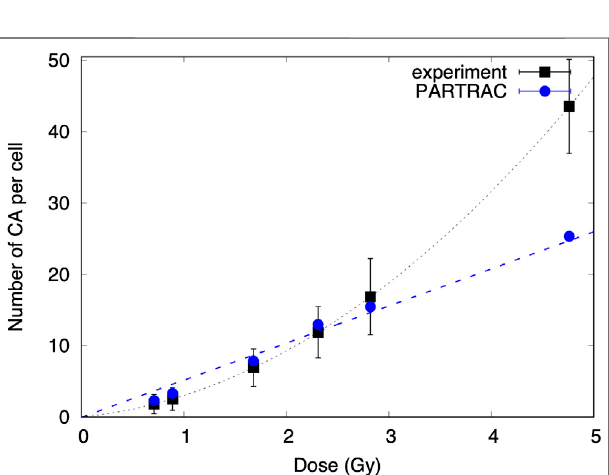
FIGURE 6 | The number of chromosomal aberrations scored for a cell induced by mixed beams as a function of the dose for experimental data and MC